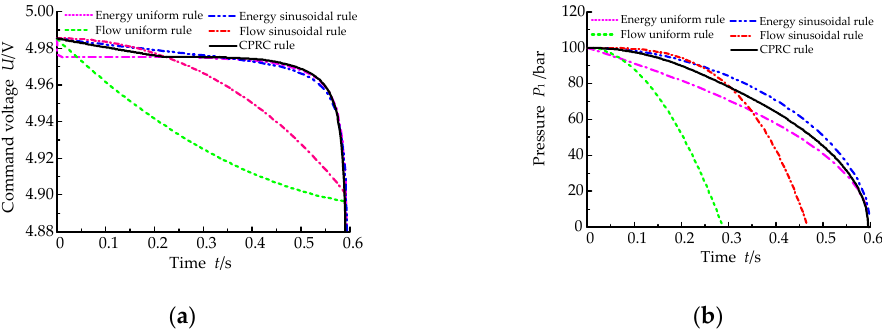
Figure 7. The simulation curve under the CPRC rule. ( a ) Eccentric magnitude curve; ( b ) Calculation CPRC. Using the above variable-pump eccentric magnitude variation curve, the working cylinder simulation pressure-relief curve and the corresponding variable-pump eccentric magnitude curve under di ff erent pressure-relief rules are obtained, as shown in Figure 8.